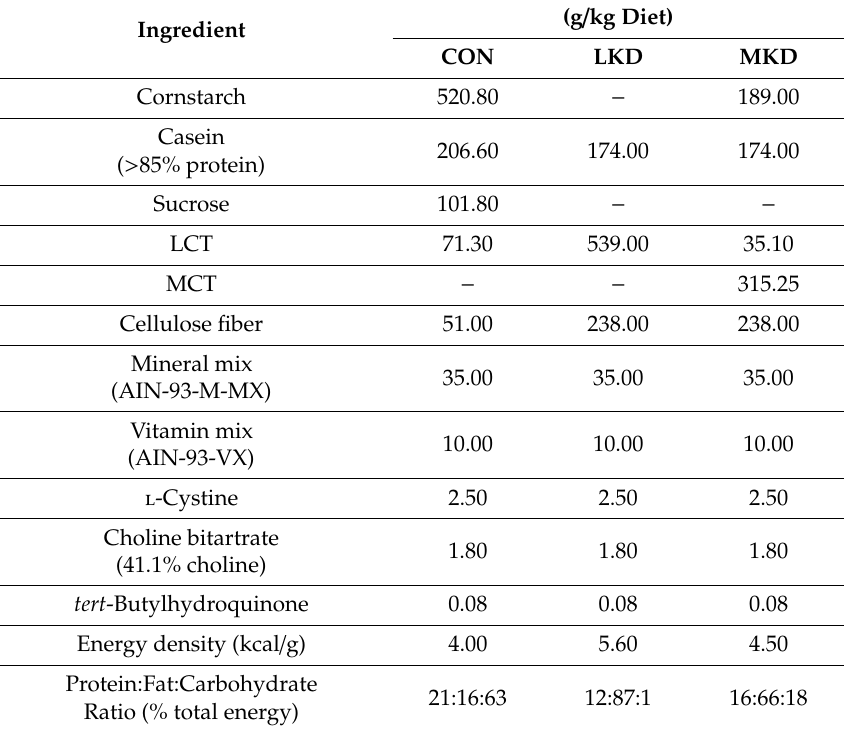
Table 1. Compositions of the experimental diets.